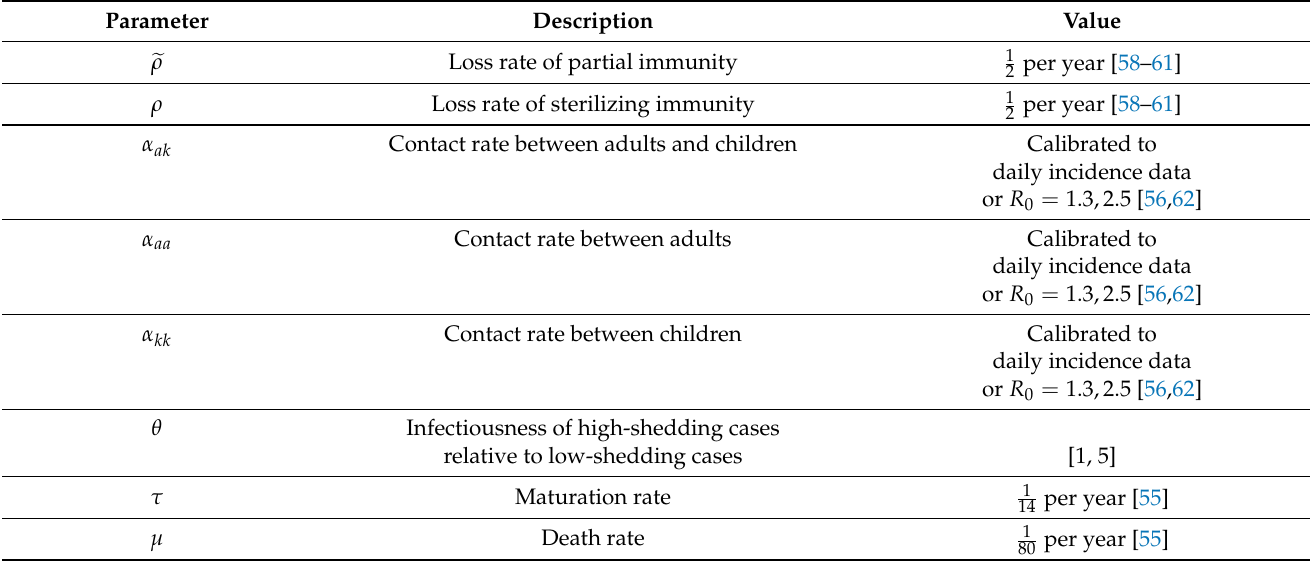
Table 2. Parameters for the full